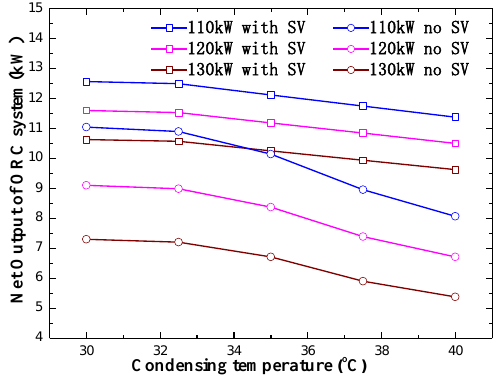
Figure 18. Net power output of ORC system vs. condensing temperature.